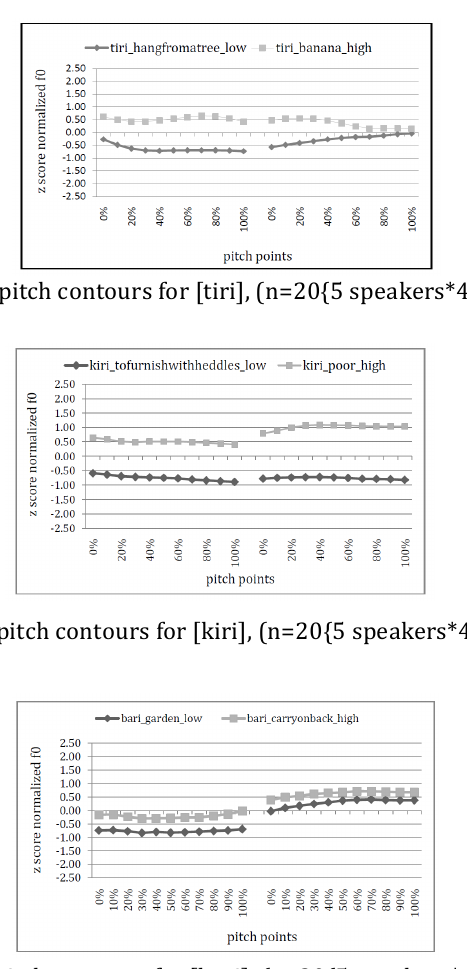
Figure 16: Normalized pitch contours for [bari], (n=20{5 speakers*4 iterations